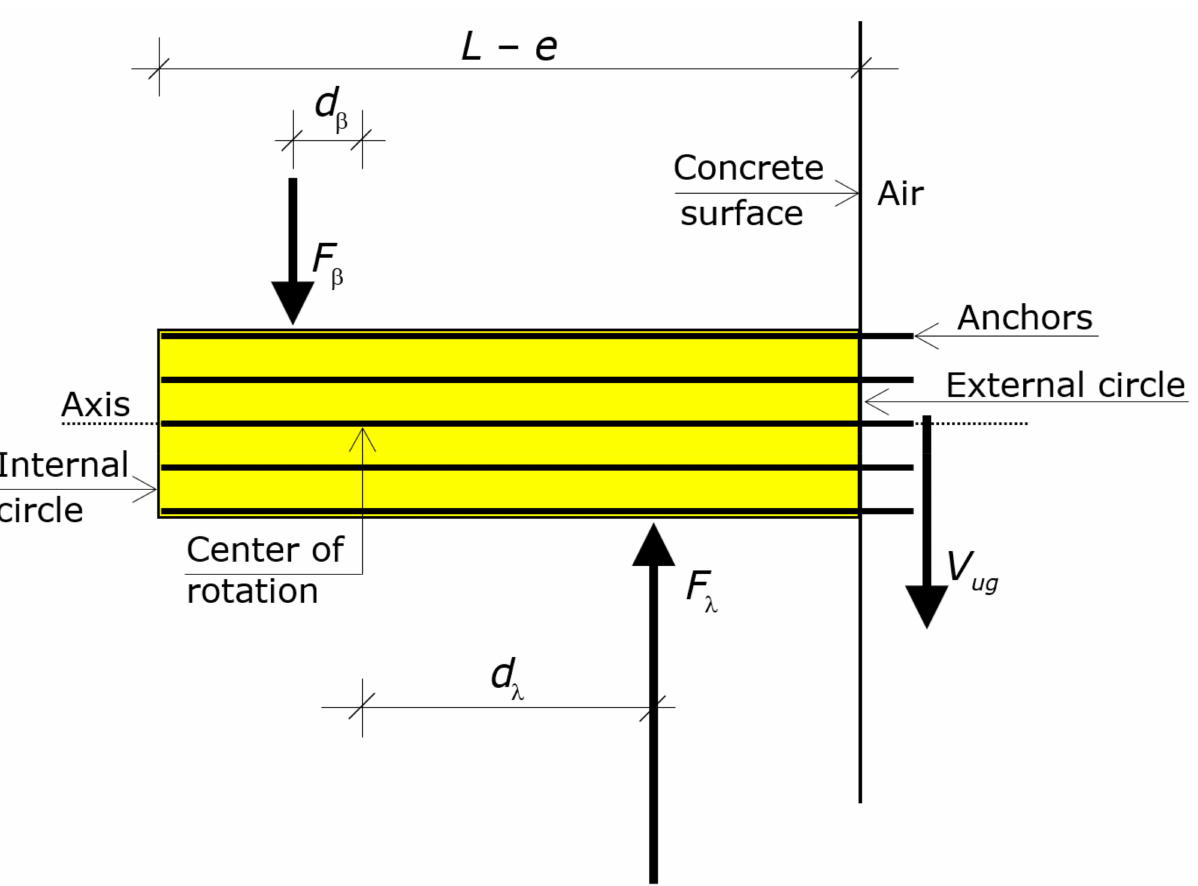
Figure 5. Internal forces F λ and F β acting on the circumscribing cylinder at ultimate and relevant application points, including the distances from the rotation center d λ d β ,